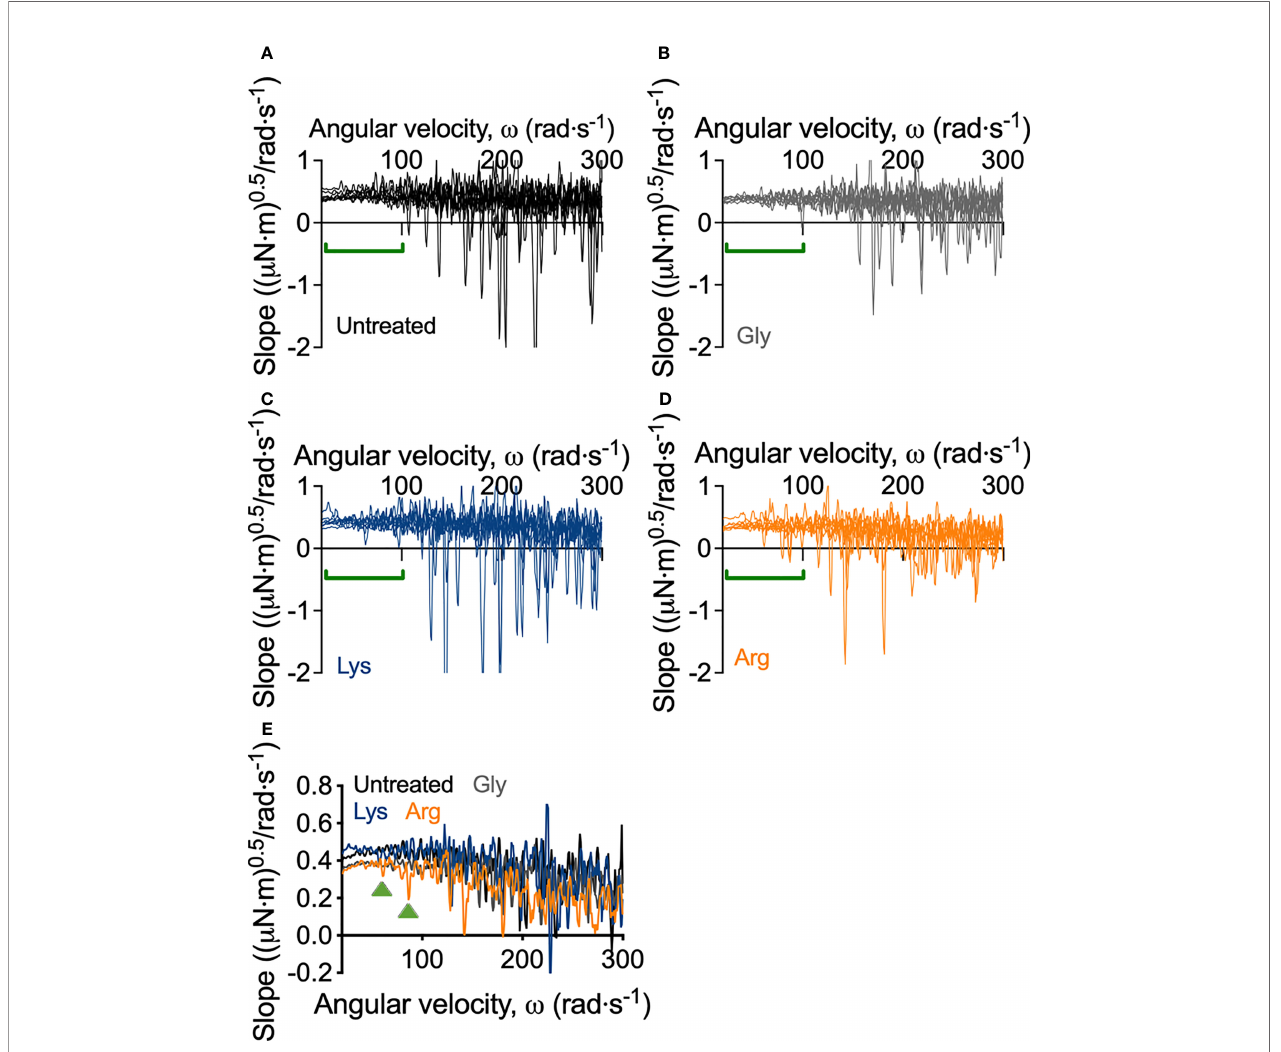
FIGURE 4 | Transformed linearized analysis of untreated and amino acid treated S. gordonii bio fi lms. Curves of individual replicates of (A) untreated S. gordonii bio fi lms and bio fi lms treated with (B) glycine, (C) lysine, and (D) arginine. Data presented as mean ± 95% con fi dence interval is depicted in Figure S4 . (E) Data from (A – D) presented as mean. Green brackets (A – D) and arrows (E) highlights regions where changes in torque, depicted here as negative slope values, were observed for arginine-treated bio fi lms, but not for glycine- or lysine-treated or untreated bio fi lms. 4 biological replicates were performed, with 2 bio fi lms analyzed for each replicate (total N =